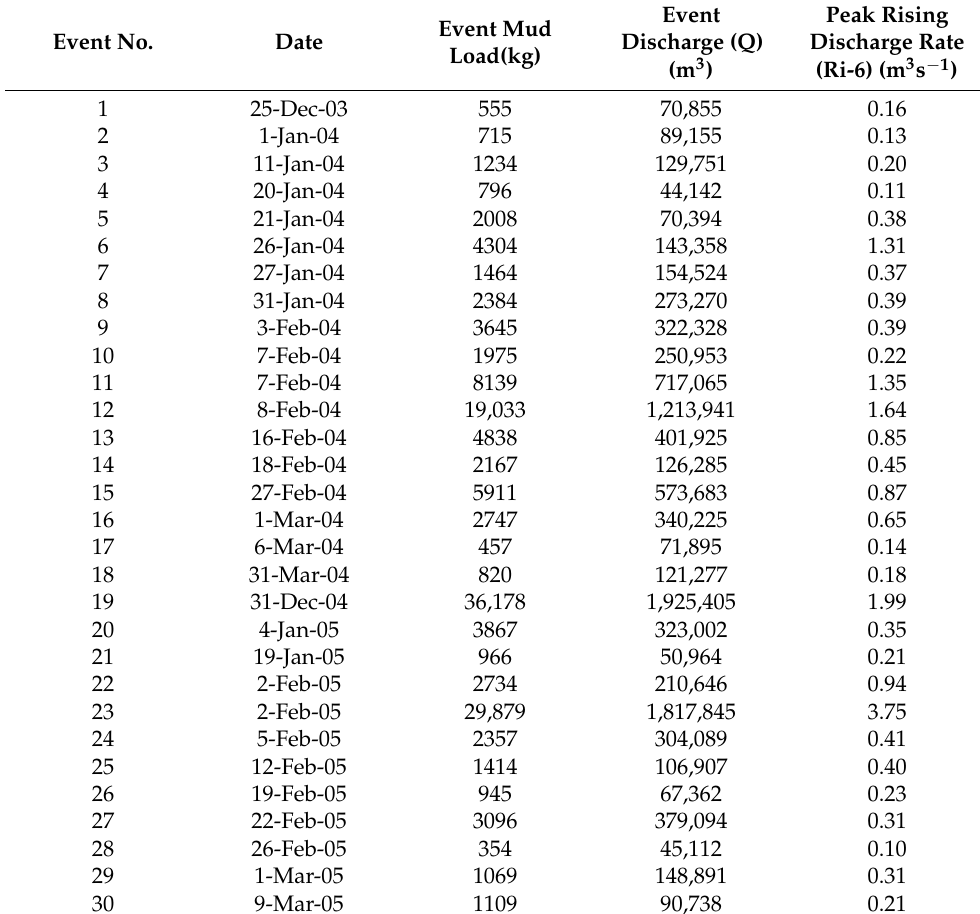
Table A2. GCUS event data